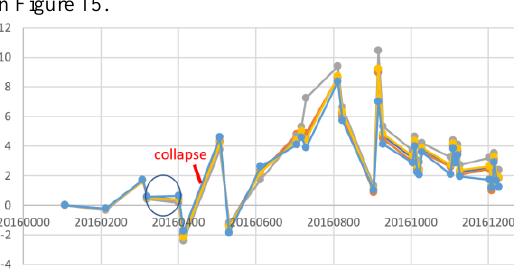
Figure 15. Displacement on Building 3 location, and its neighbours.